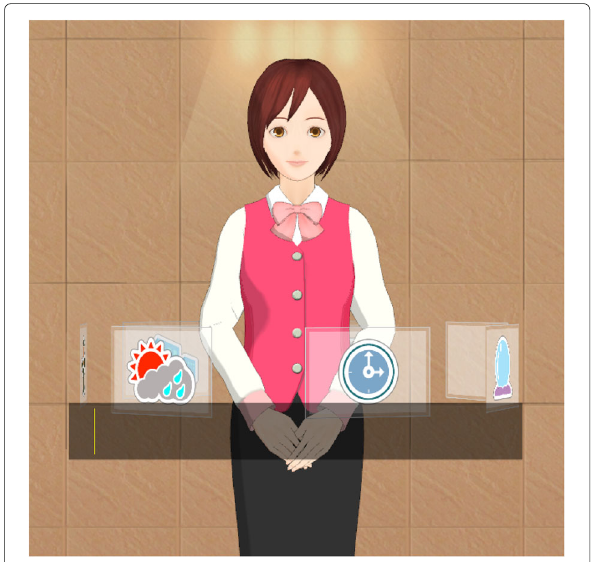
Fig. 1 Example of a spoken dialog system created with